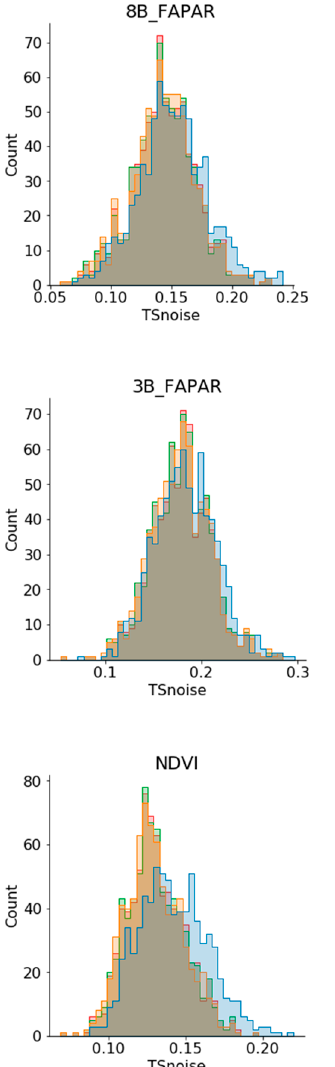
Figure 11. Histograms of time series noise calculated for the different BIOPARs and NDVI for the original data and the different harmonization measured applied on the dataset (colors) for the HESBANIA site.